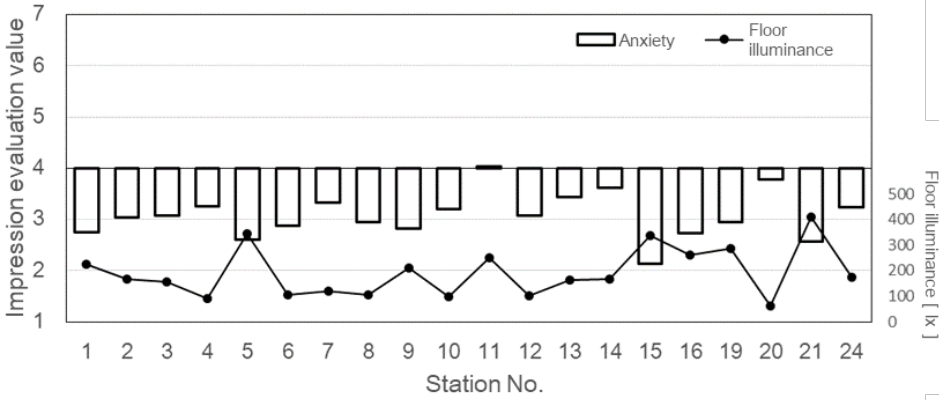
Figure 17. Results of the impression evaluation of anxiety and floor illuminance.